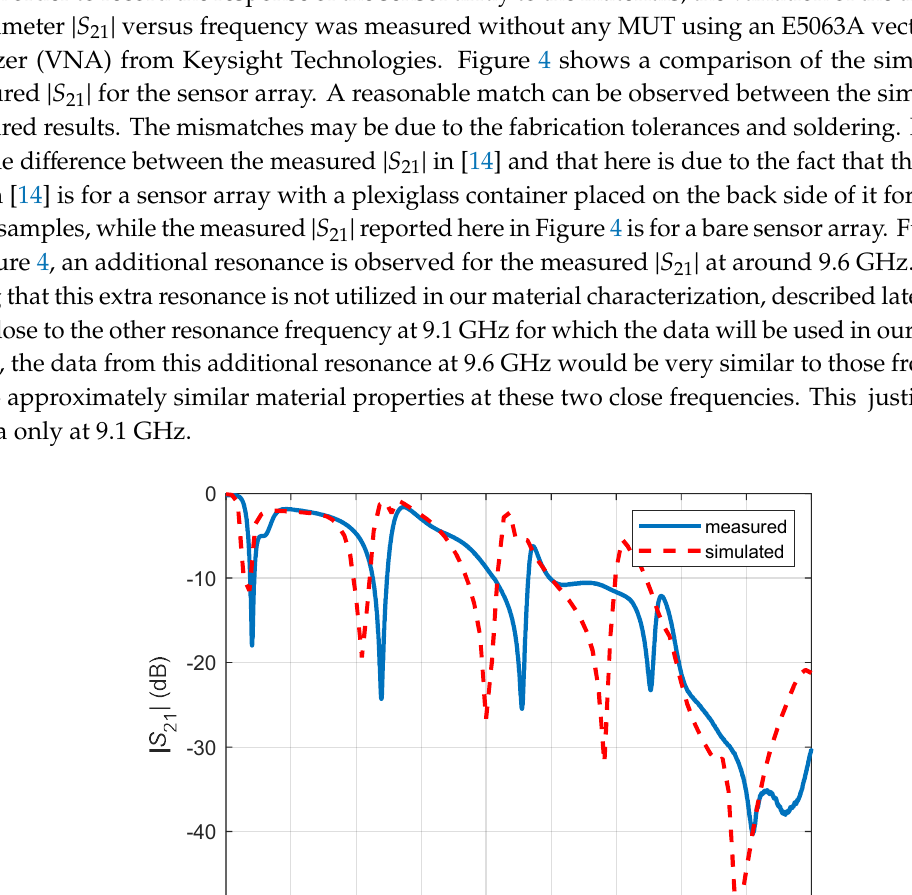
Figure 4. Simulated and measured | S 21 | for the sensor array.